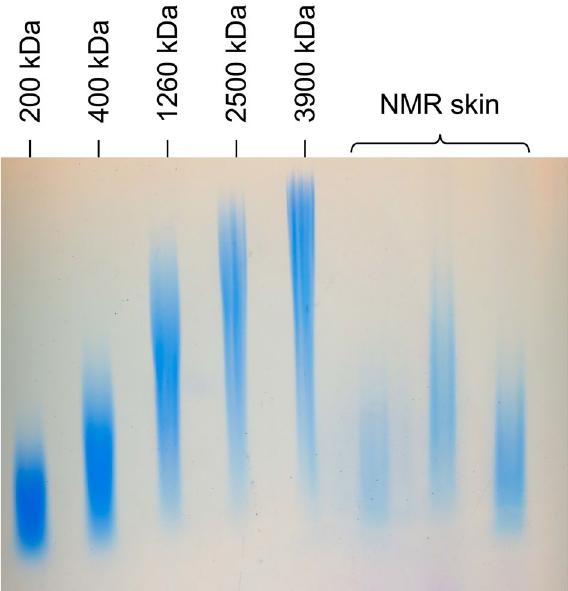
Figure 6. Agarose gel electrophoresis of HA in NMR skin samples. NMR skin samples (n = 3) and HA standards of 200 kDa, 400 kDa, 1260 kDa, 2500 kDa, and 3900 kDa, analyzed using agarose gel electrophoresis and Stains all detection (cropped gel). Full-length blots/gels are presented in Supplementary Fig.